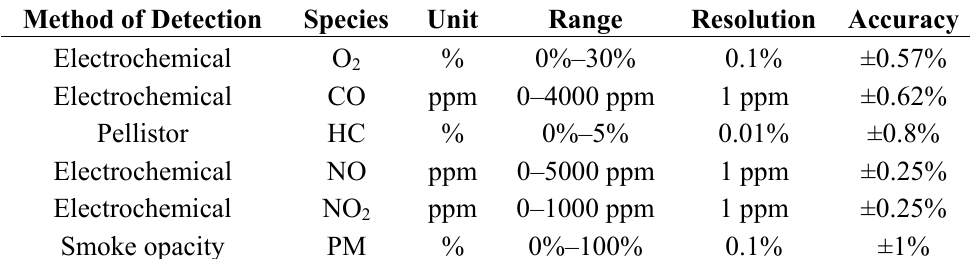
Table 4. Specifications of the exhaust gas